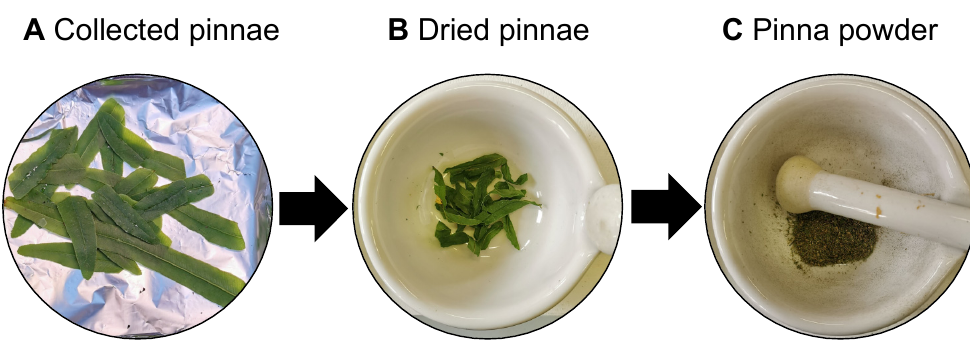
Figure 1. A P. vittata plant grown in naturally As-rich soil under greenhouse conditions. The arrow indicates the pinna collected for preparing pinna powder.